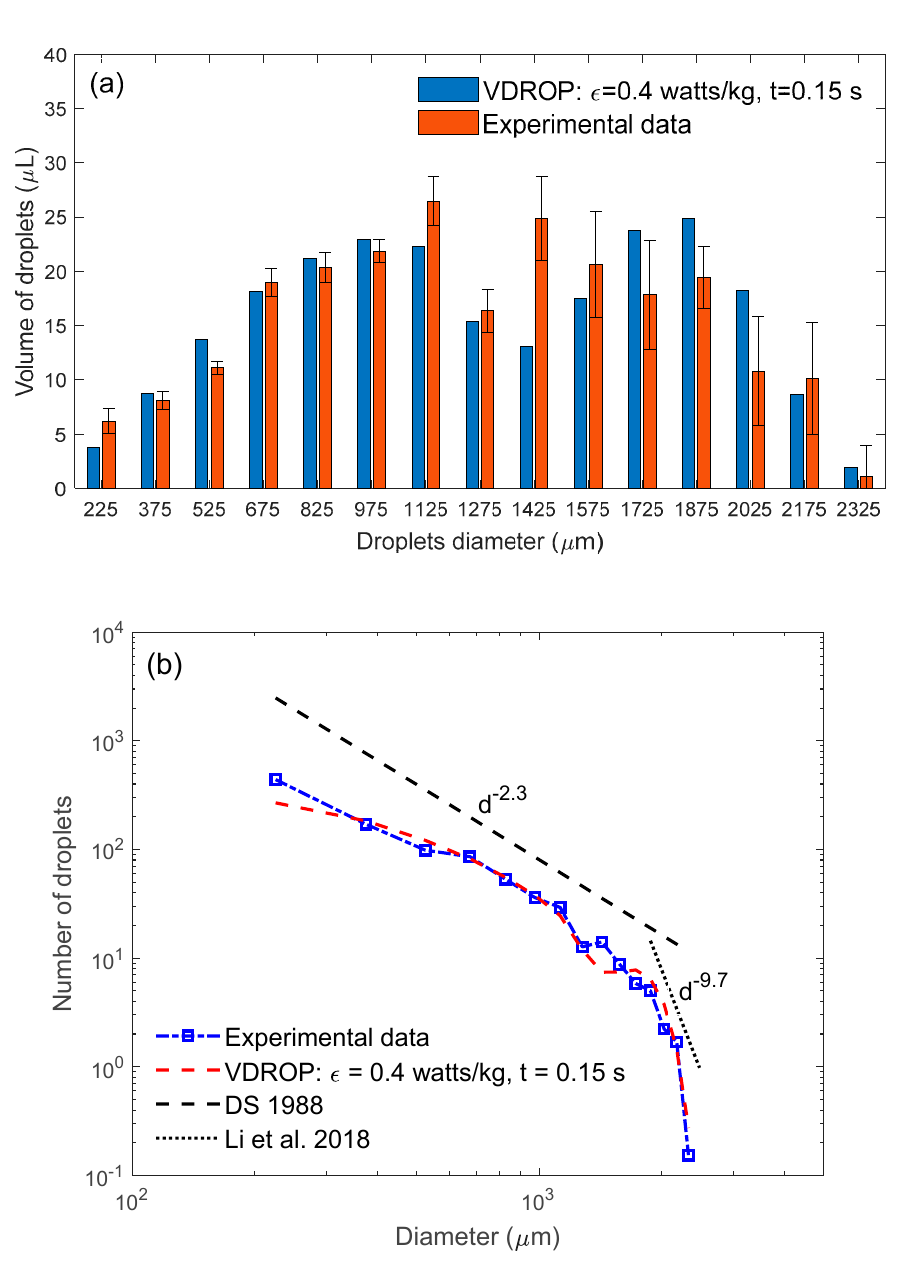
Figure 9. Droplet size distribution (DSD) obtained from the experiments and the VDROP simulation. ( a ) Volume-based DSD and ( b ) number-based DSD (note the logarithmic scale in ( b )). Error bars in ( a ) represent the standard deviation of each size class. The power–law correlations reported in the literature are also shown. The cumulative volume-based DSD is reported in Figure A3.